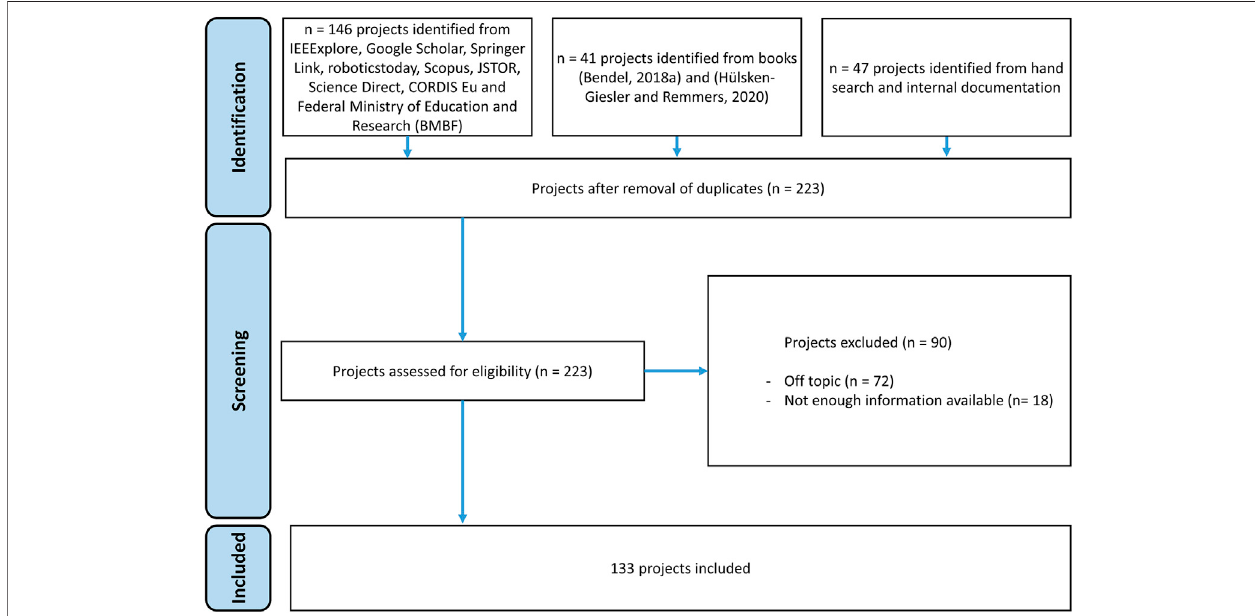
FIGURE 5 | Search results and projects selection process.